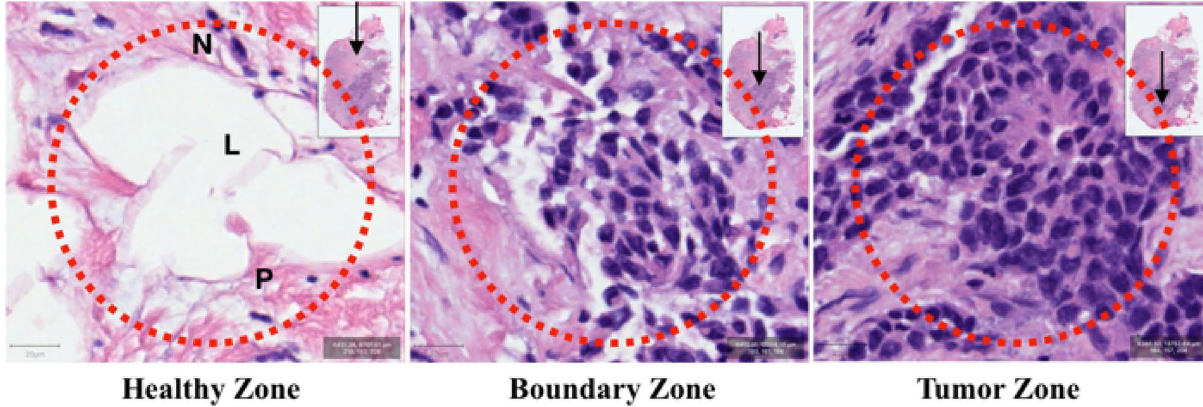
Figure 7. Tumor heterogeneity and laser spot size Laser spot size of 85 μm diameter (dotted red ring) superimposed on 100 × 100 μm regions from healthy, boundary, and tumor zones. Paraffin-filled white spaces (L) were lipid-rich in vivo. These healthy cells are surrounded by protein-rich supporting stroma (P). Cell nuclei (N) rich in DNA, RNA, and peri-nuclear proteins occur infrequently in healthy regions and increasingly dominate in boundary and tumor regions. Scale bar in lower left corner is 20 μm. Inset shows location (black arrow) of zones on the H&E slide.